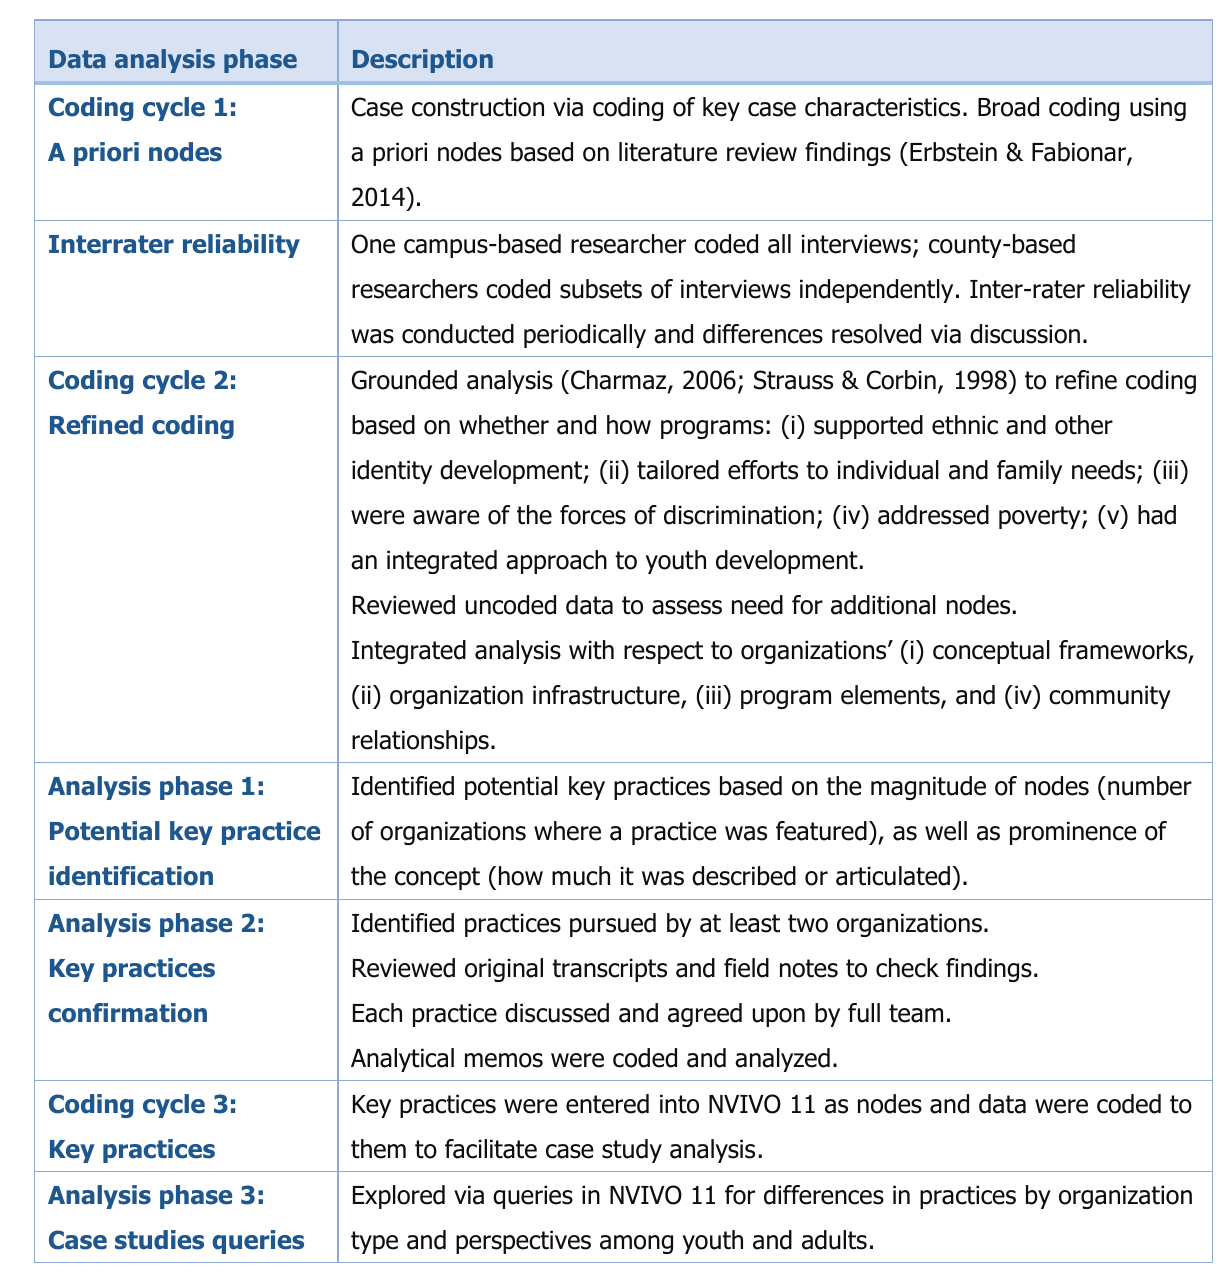
Table 3. Data Analysis